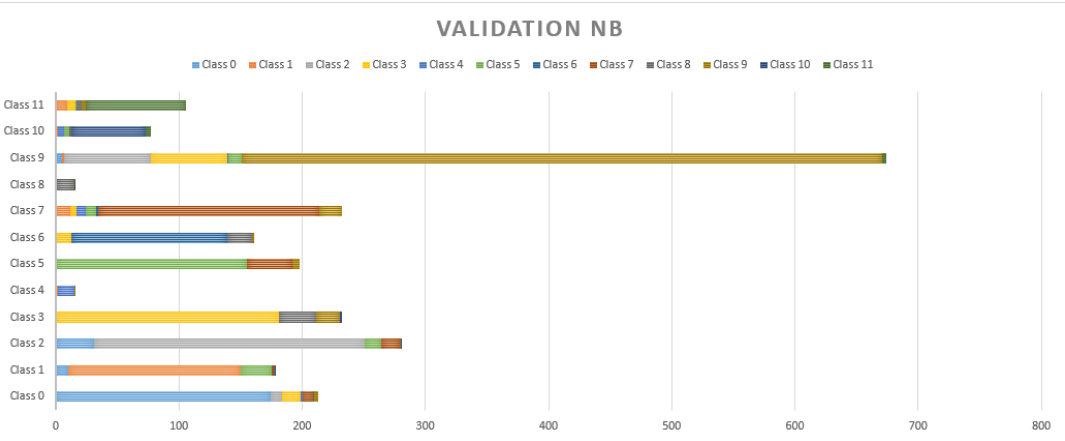
Figure 10. Cross-validation results with 20% for the